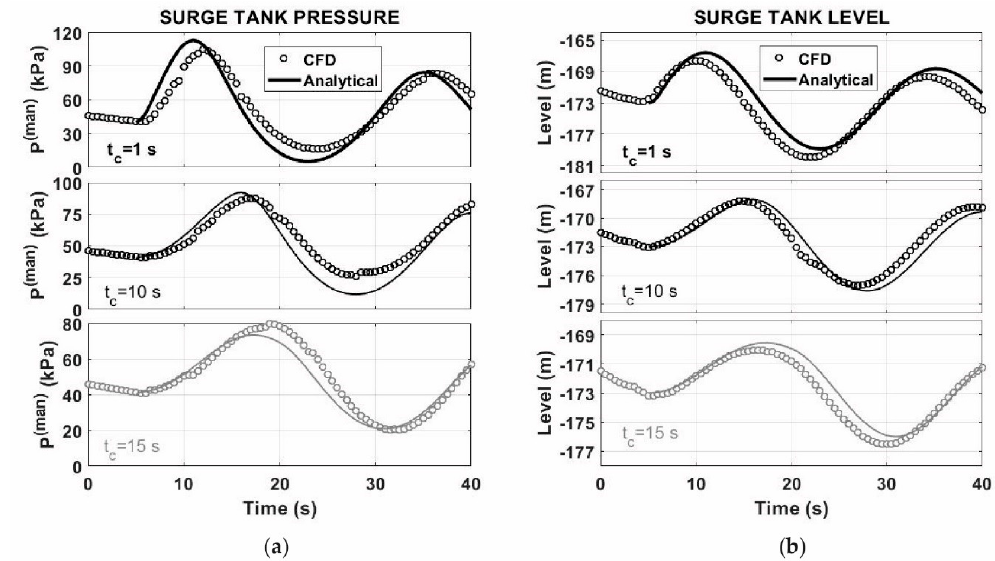
Figure 14. Comparison between analytical and CFD results for different closing schemes. ( a ) Surge tank air pressure rise for t c =1, t c =10, and t c =15 s; and, ( b ) Surge tank water level fluctuation for t c =1, t c =10, and t c =15 s.